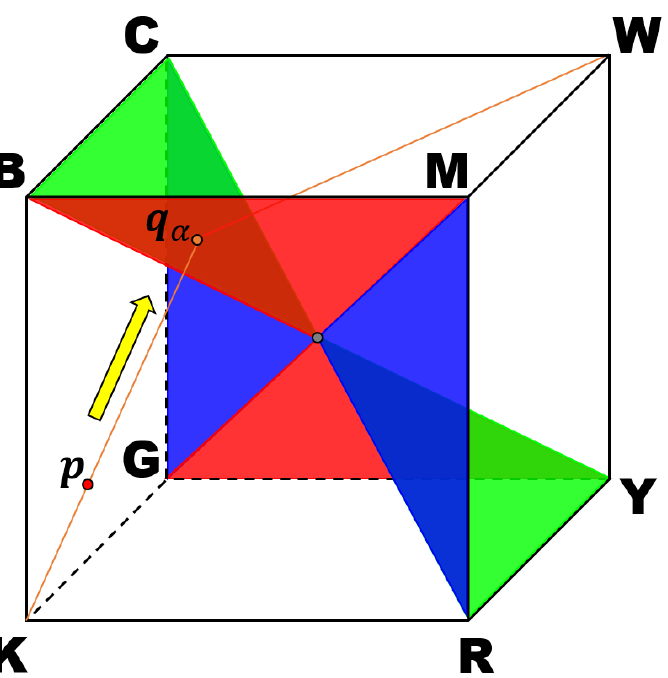
Figure 4. RGB color space, illustrated by a cube is bisected by a boundary surface, which passes through the center of the space. The letters attached to the vertices of the cube denote eight ba- sic colors, normalized as follows: K = [ 0,0,0 ] T , R = [ 1,0,0 ] T , G = [ 0,1,0 ] T , B = [ 0,0,1 ] T , C = [ 0,1,1 ] T , M = [ 1,0,1 ] T , Y = [ 1,1,0 ] T and W = [ 1,1, 1 ] T . Every color point in the space can be projected onto the surface to increase the